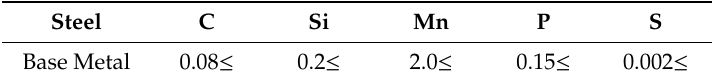
Figure 2. Residual stress distribution of low heat input and high heat input weld joint in 70 mm: ( a ) weld metal, ( b ) heat a ff ected zone. Table 1. Chemical composition of the HSB600 steel plate used.